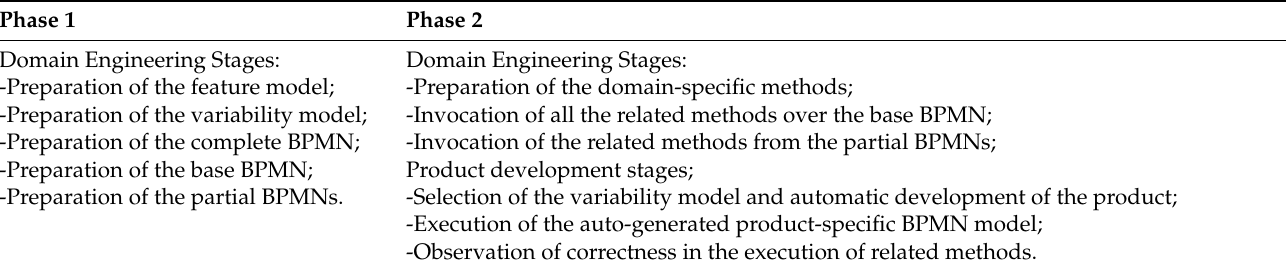
Table 3. The experimental study